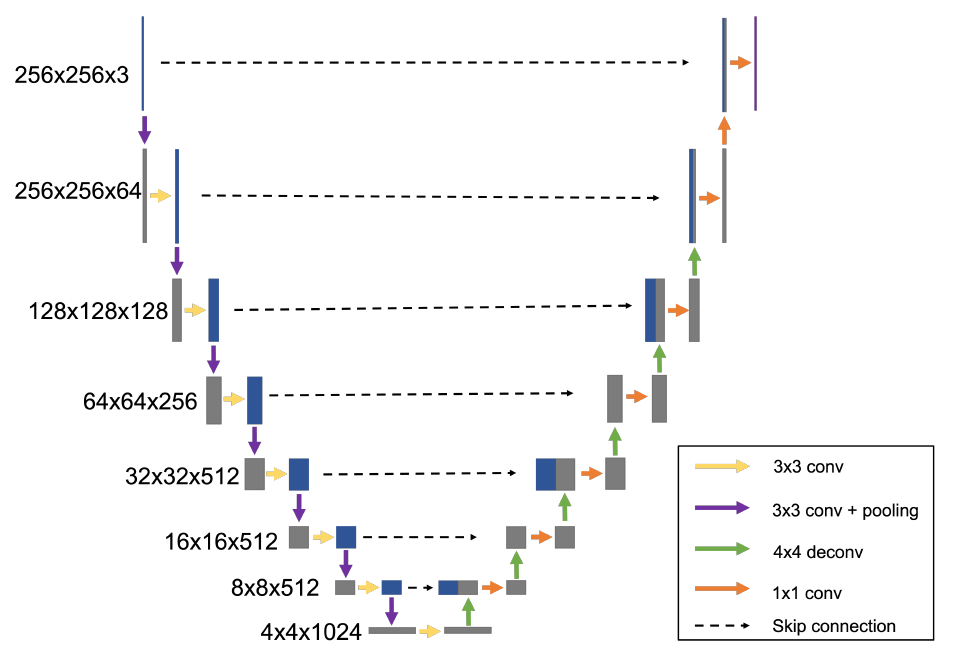
Figure 2. Our HSVNet architecture with